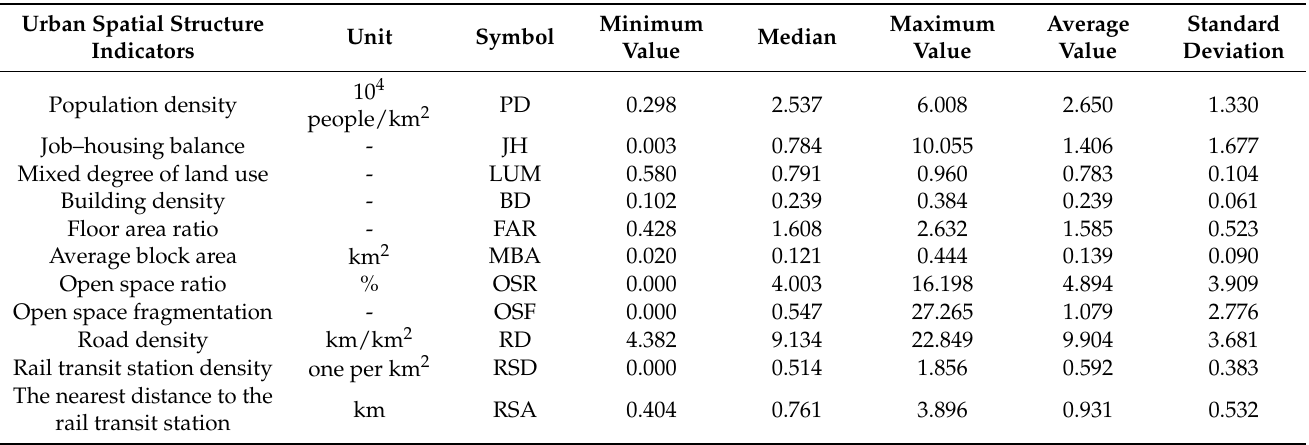
Figure 6. Binary spatial correlation between urban spatial structure and urban vitality. Note: *, **, and *** indicate pseudo p -value not greater than 0.05, 0.01, and 0.001.